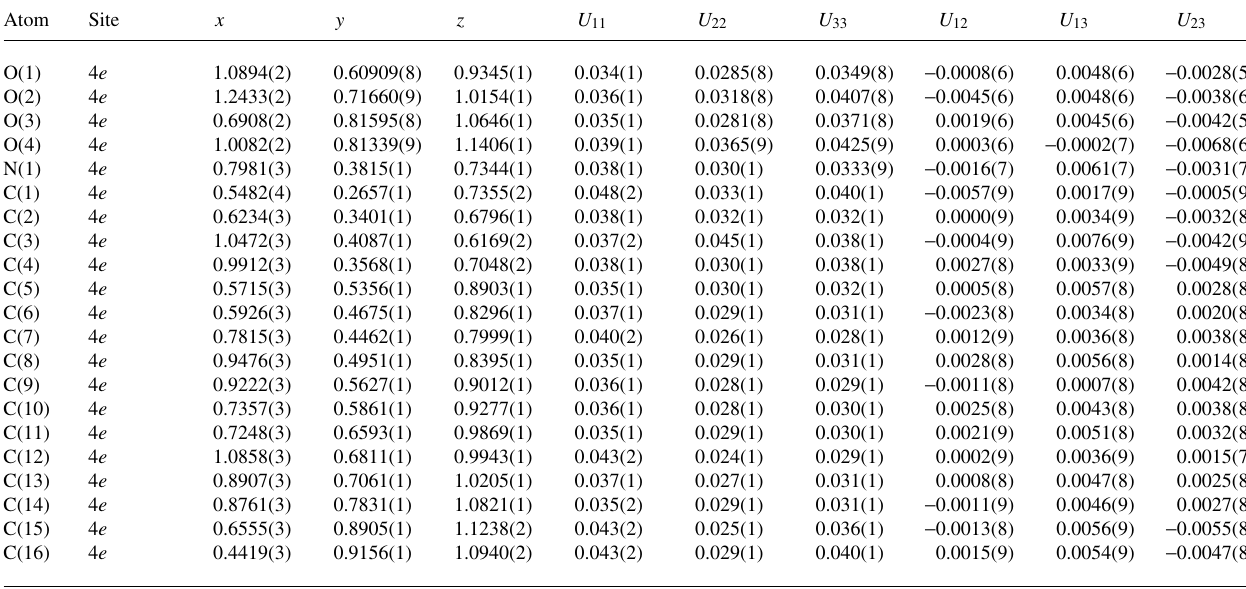
Table 3. Atomic coordinates and displacement parameters (in Å 2 ) .